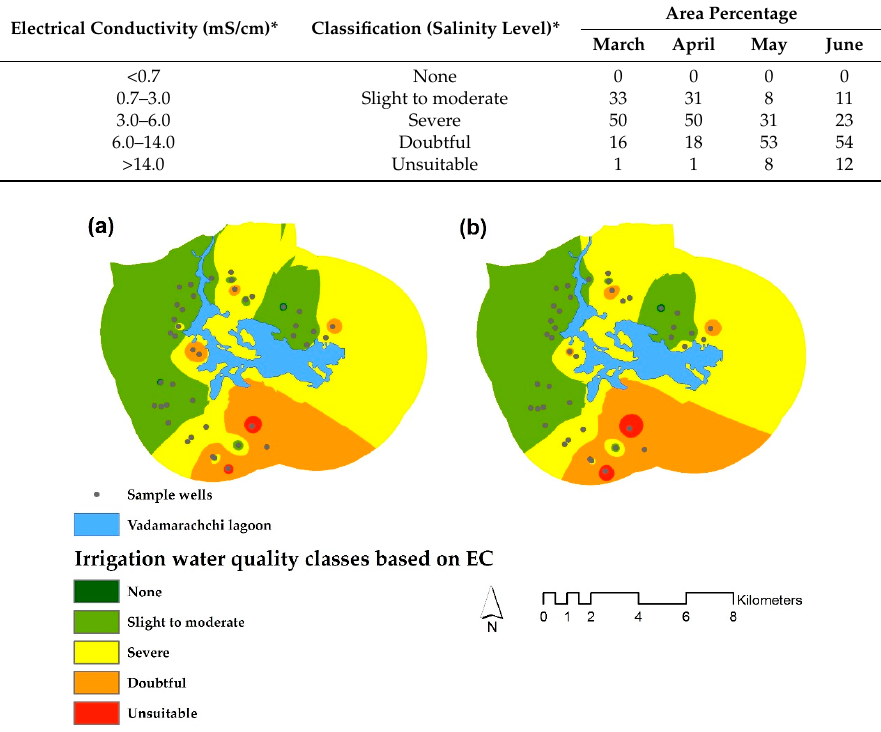
Table 2. Classification of groundwater for irrigation based on Food and Agriculture Organization of the United Nations irrigation water quality guidelines.